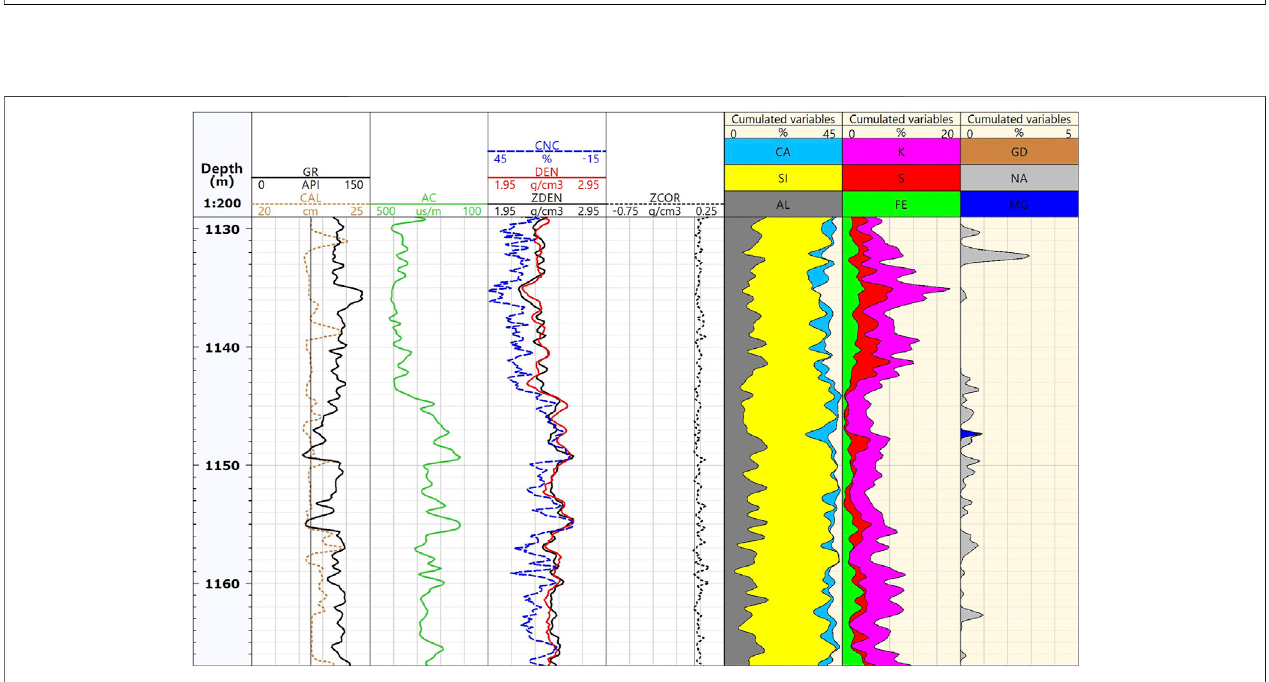
FIGURE13| Densitycomparisoninasand-shalylayer.Theneutron-gammadensitymeasurements(track3,red)andconventionalgammadensitymeasurements (black) are highly consistent. The data above are clearly separated from thermal neutron porosity data (blue) in the sand-shaly formation.